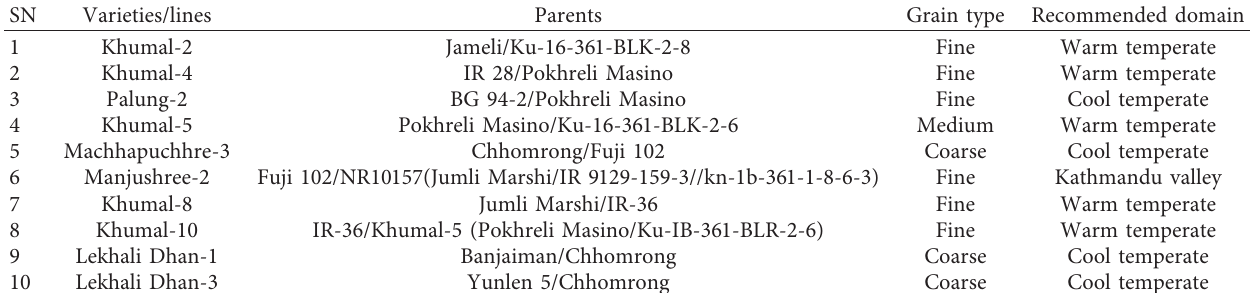
Table 2: List of rice varieties developed using landraces in Nepal [25]. SN